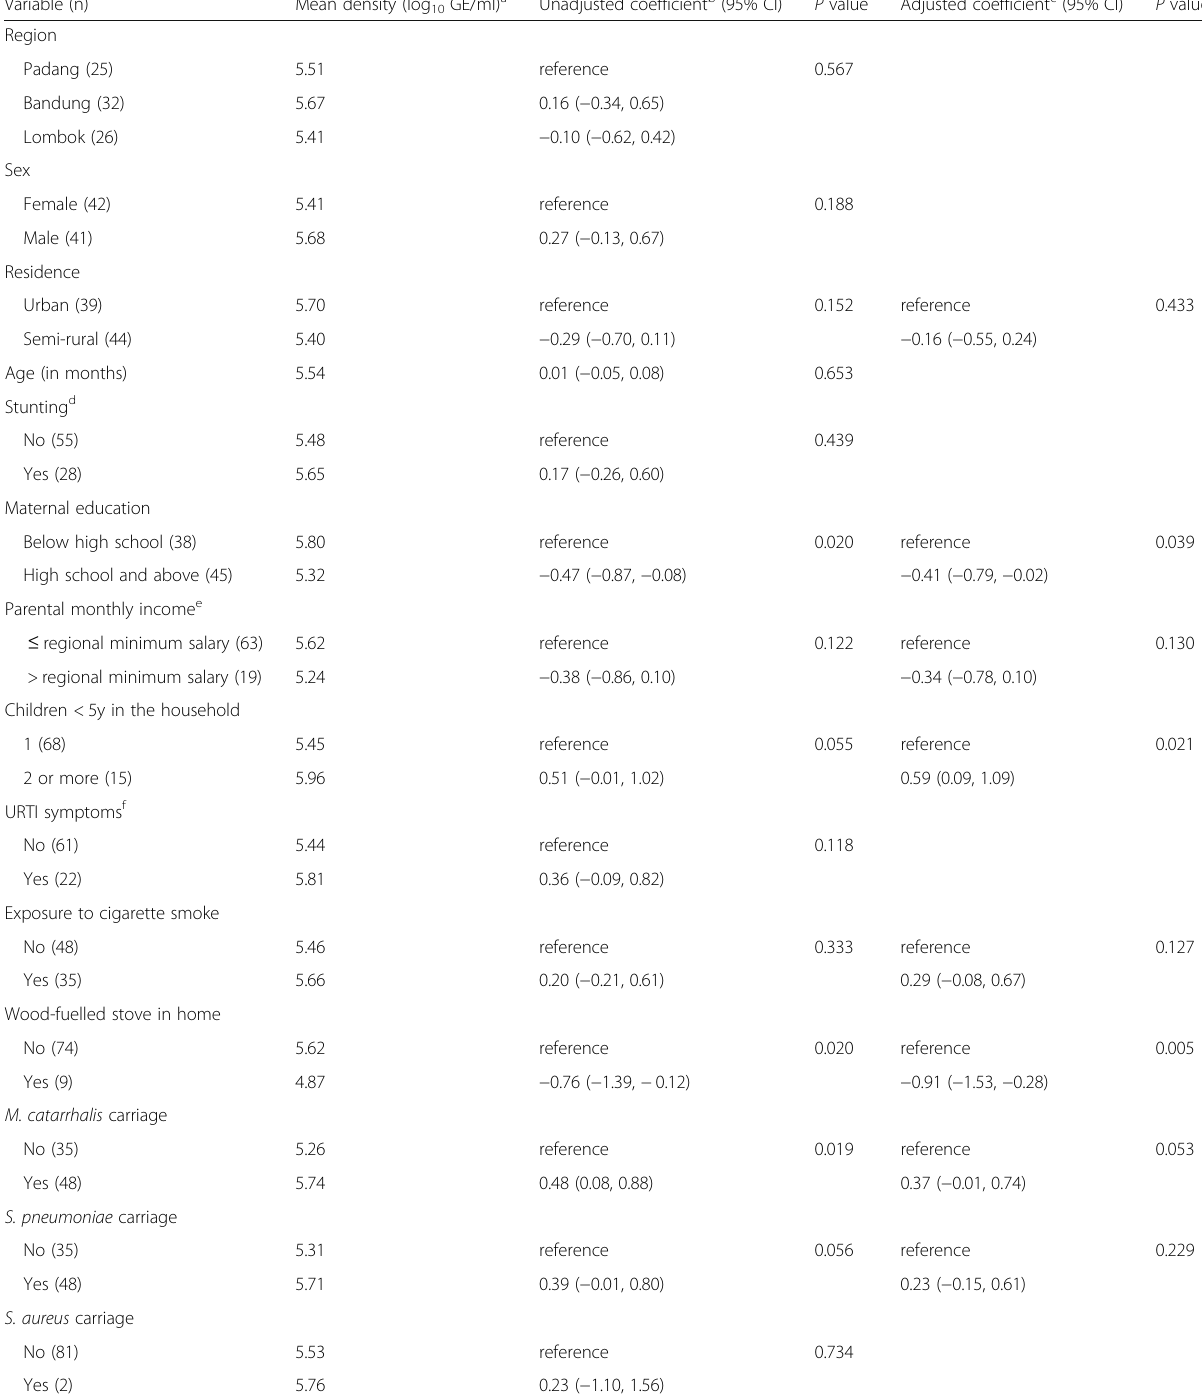
Table 4 Linear regression analysis of factors associated with H. influenzae density in children who are carriers ( n = 83) Variable